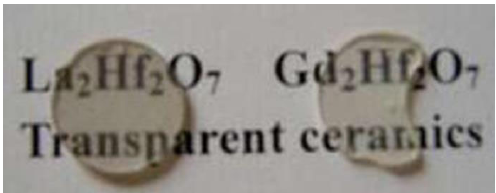
Fig. 4 Photograph of Ln 2 Hf 2 O 7 (Ln = La, Gd) ceramics sintered at 1850 ℃ for 6 h. Reproduced with permission from Ref. [89], © Chinese Academy of Sciences 2006.